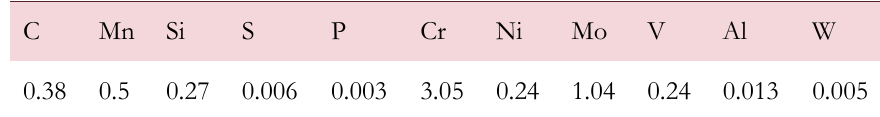
Table 2: Chemical composition wt.%, balance